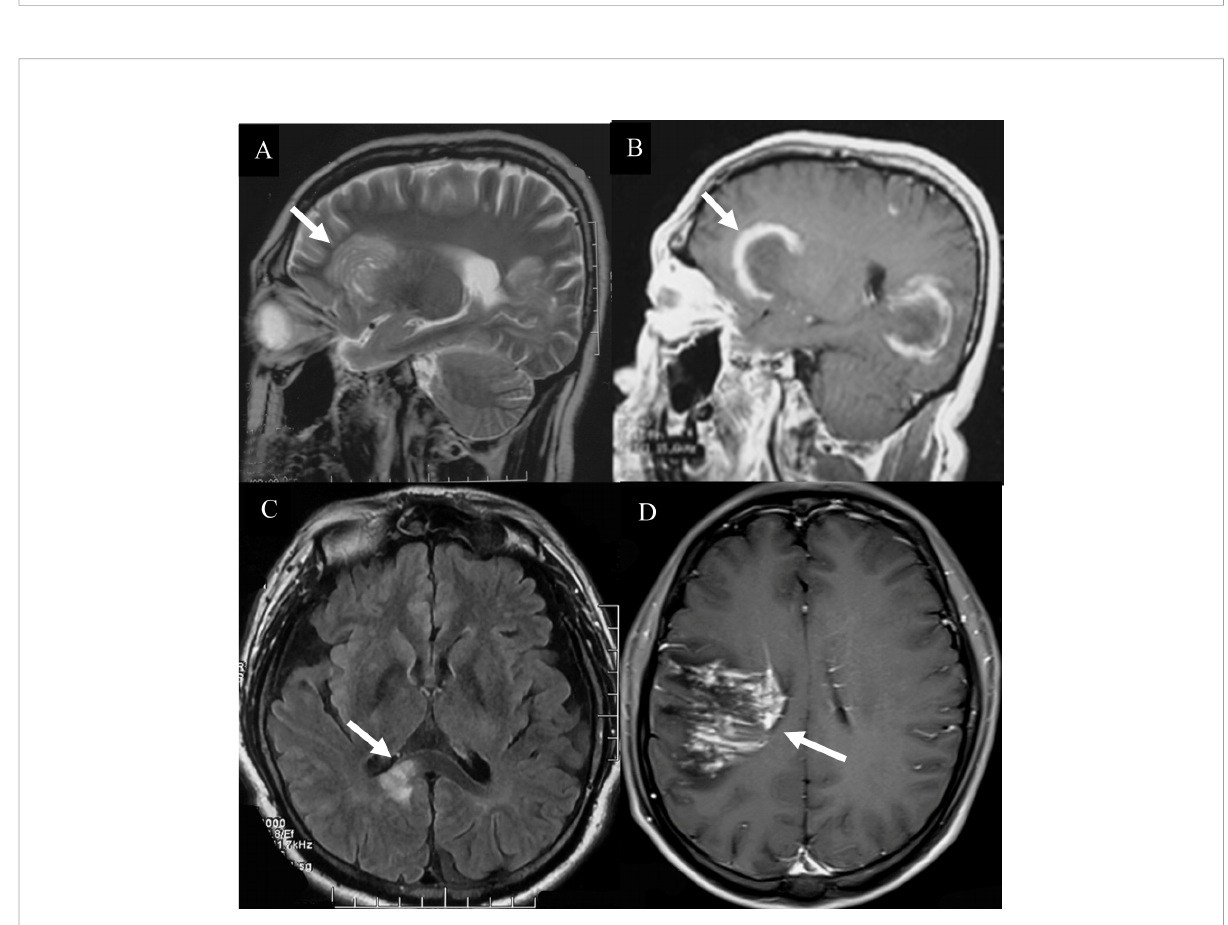
FIGURE 2 Hyperintense lesions in TDLs. (A) A Balo-like lesion (white arrow). (B) The ‘ C ’ like enhancement lesion (white arrow). (C) The lesions of TDLs without thickened corpus callosum (white arrow). (D) “ comb sign ” enhancement (white